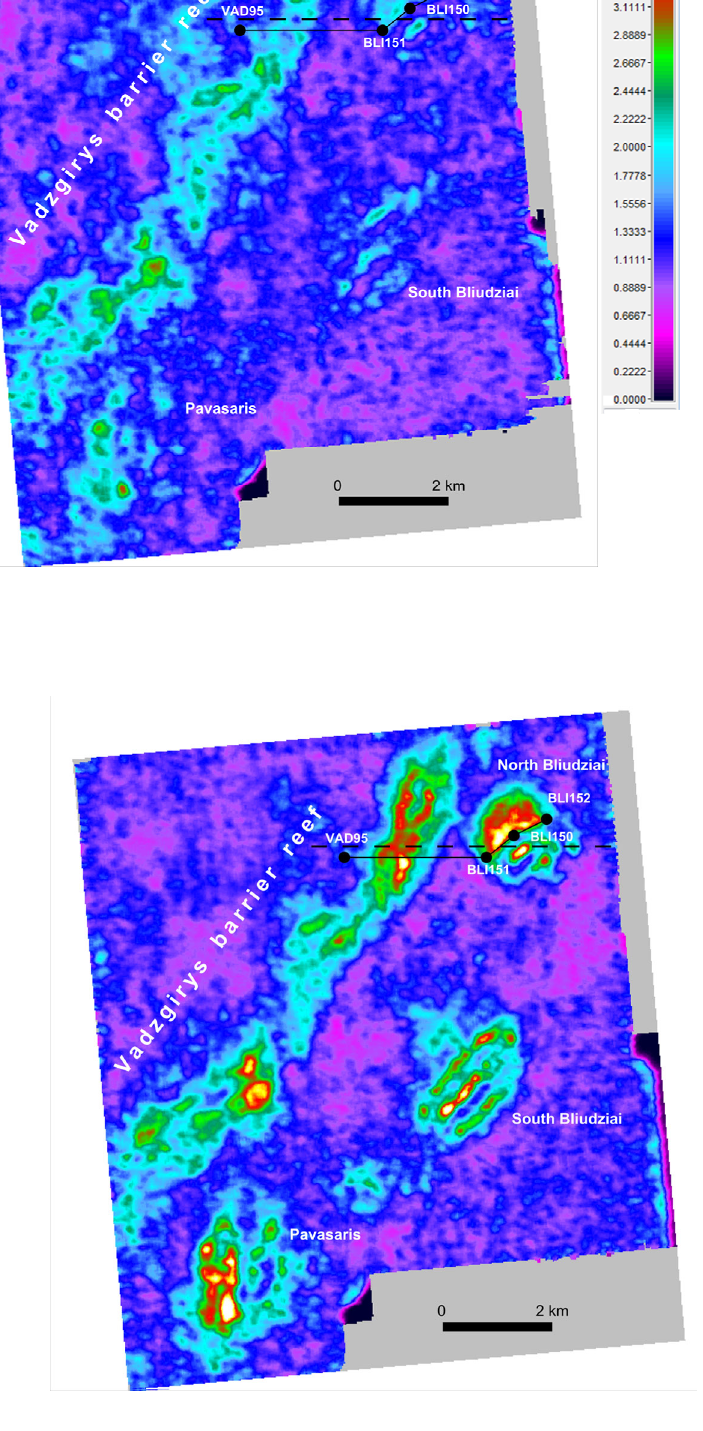
Fig. 5. Root-mean-square attribute map calculated for 90(cid:150)135 m (RMS2) from the top of the Silurian. See Fig. 4 for